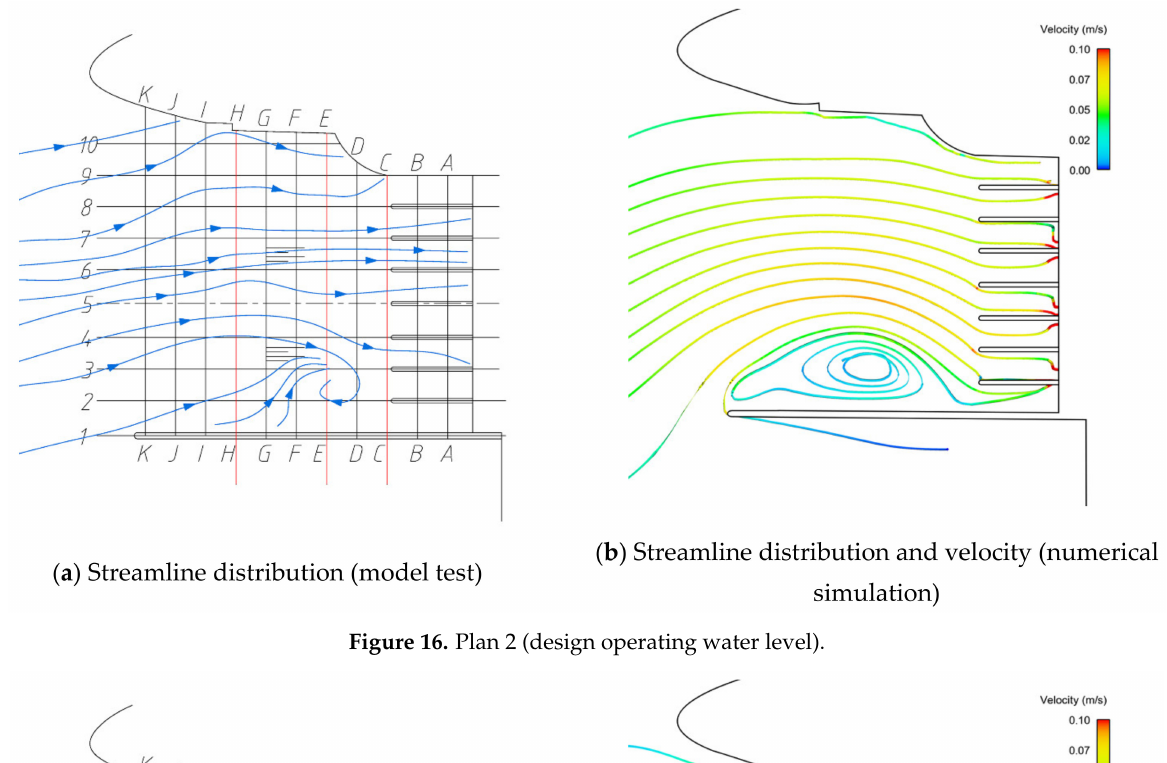
Figure 16. Plan 2 (design operating water level).